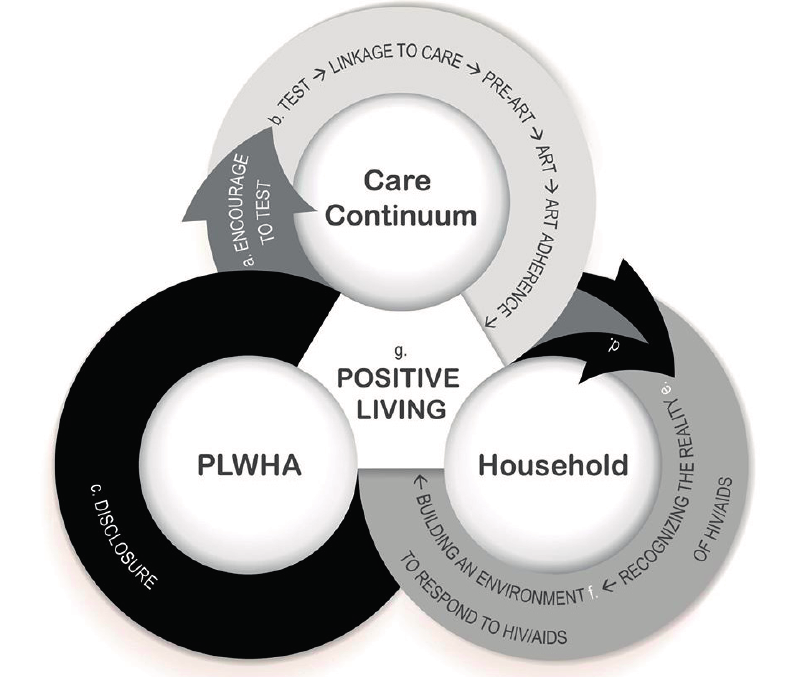
Figure 1. On the road to HIV/AIDS competence in the